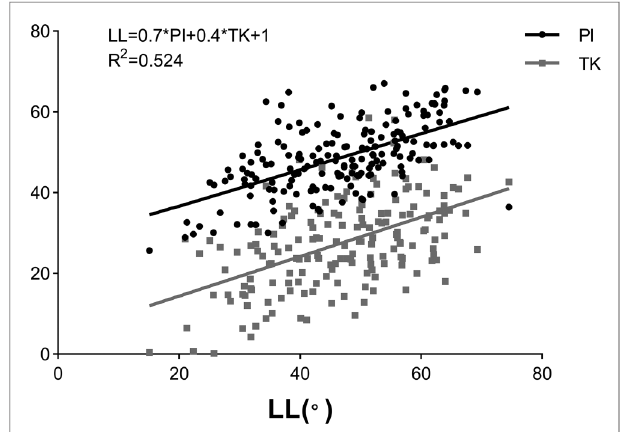
FIGURE 1 | Linear correlations of lumbar lordosis (LL) with pelvic incidence (PI) and thoracic kyphosis